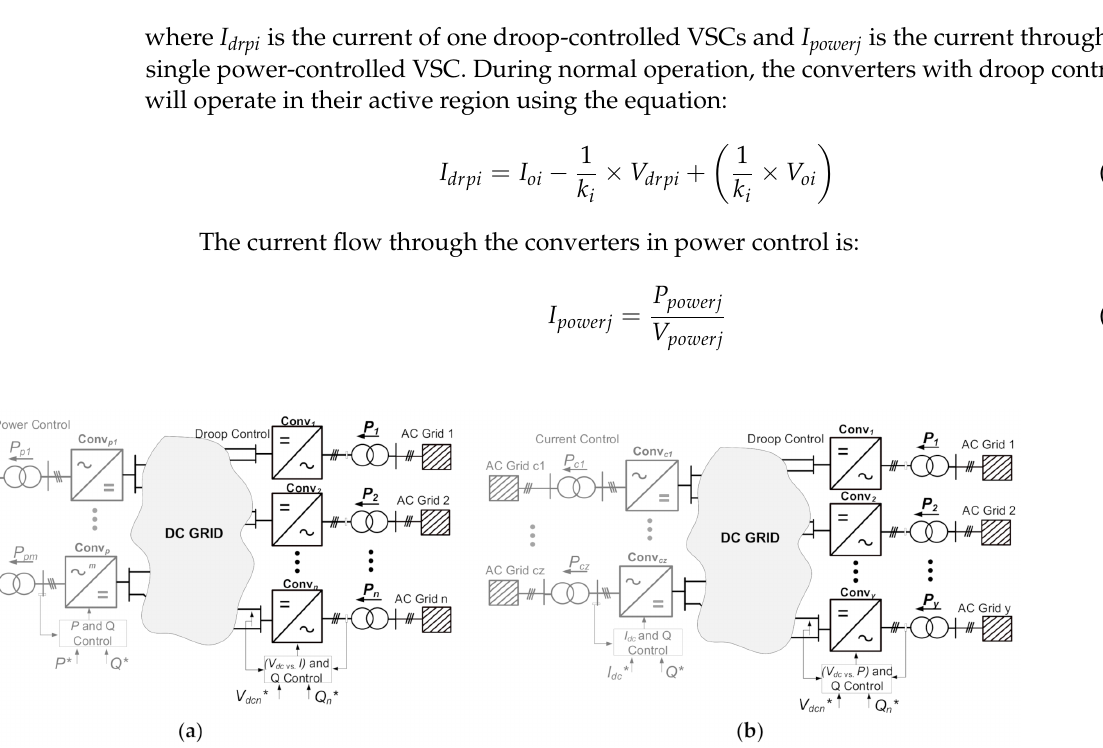
Figure 5. Schematic of a representative DC grid with control schemes. ( a ) V dc vs. I droop and power control. ( b ) V dc vs. P droop and current